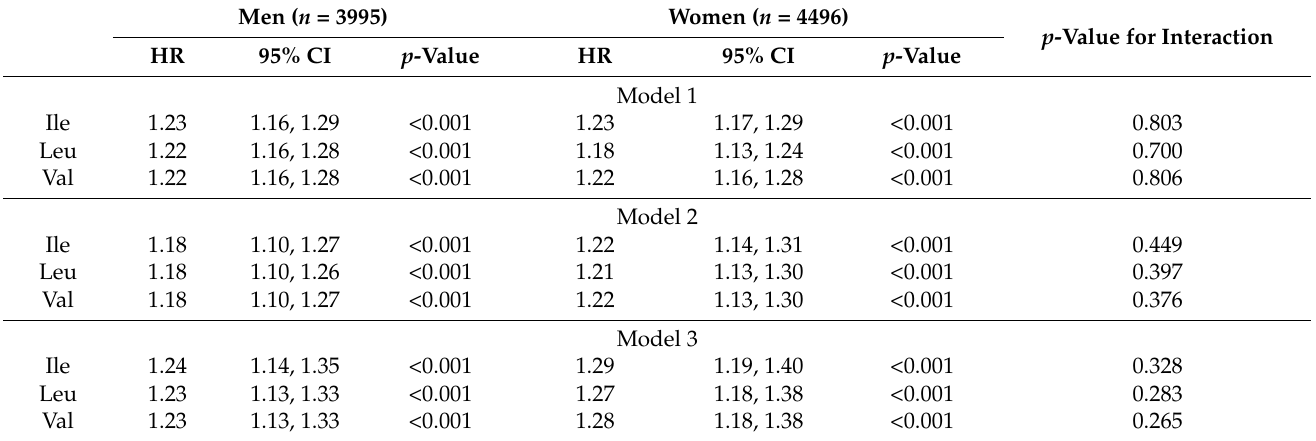
Table 3. Adjusted associations between hypertension incidence and per SD increase in BCAAs ( n =